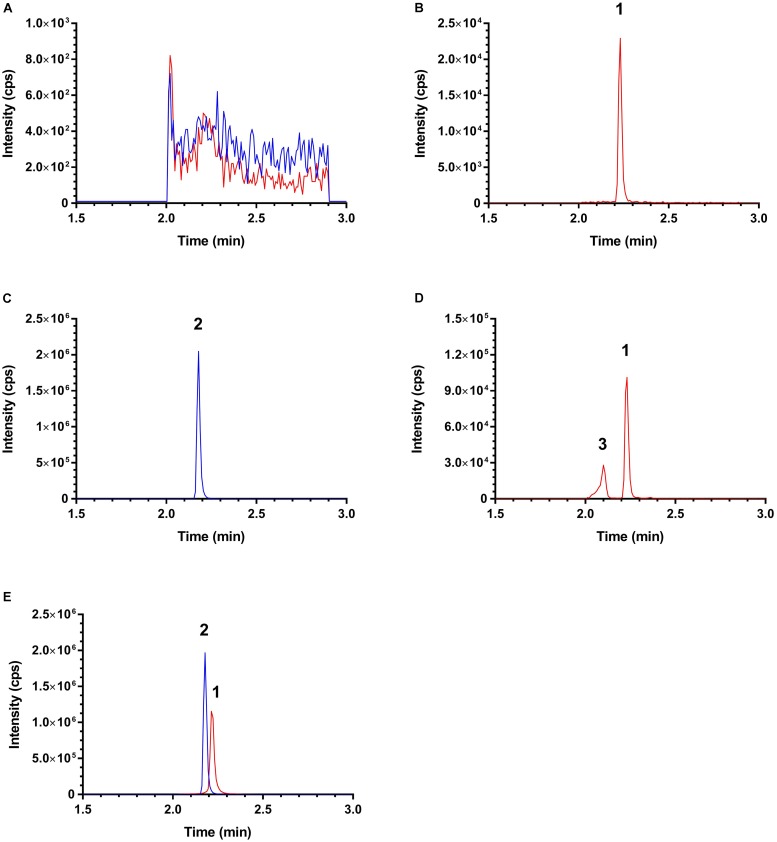
Typical MRM chromatograms of (A) a pre-dosing plasma sample; (B) a blank plasma sample spiked with 3 ng/mL isorhapontigenin; (C) a blank plasma sample spiked with 30 ng/mL internal standard; (D) a plasma sample collected 90 min after intravenous injection; and (E) a plasma sample collected 180 min after oral dosing. Red: MRM precursor-to-product ion transition of m/z 257.2 → 241.1 and blue: MRM precursor-to-product ion transition of m/z 241.0 → 181.0. Peak 1, isorhapontigenin; peak 2, internal standard; and peaks 3, unidentified metabolite.